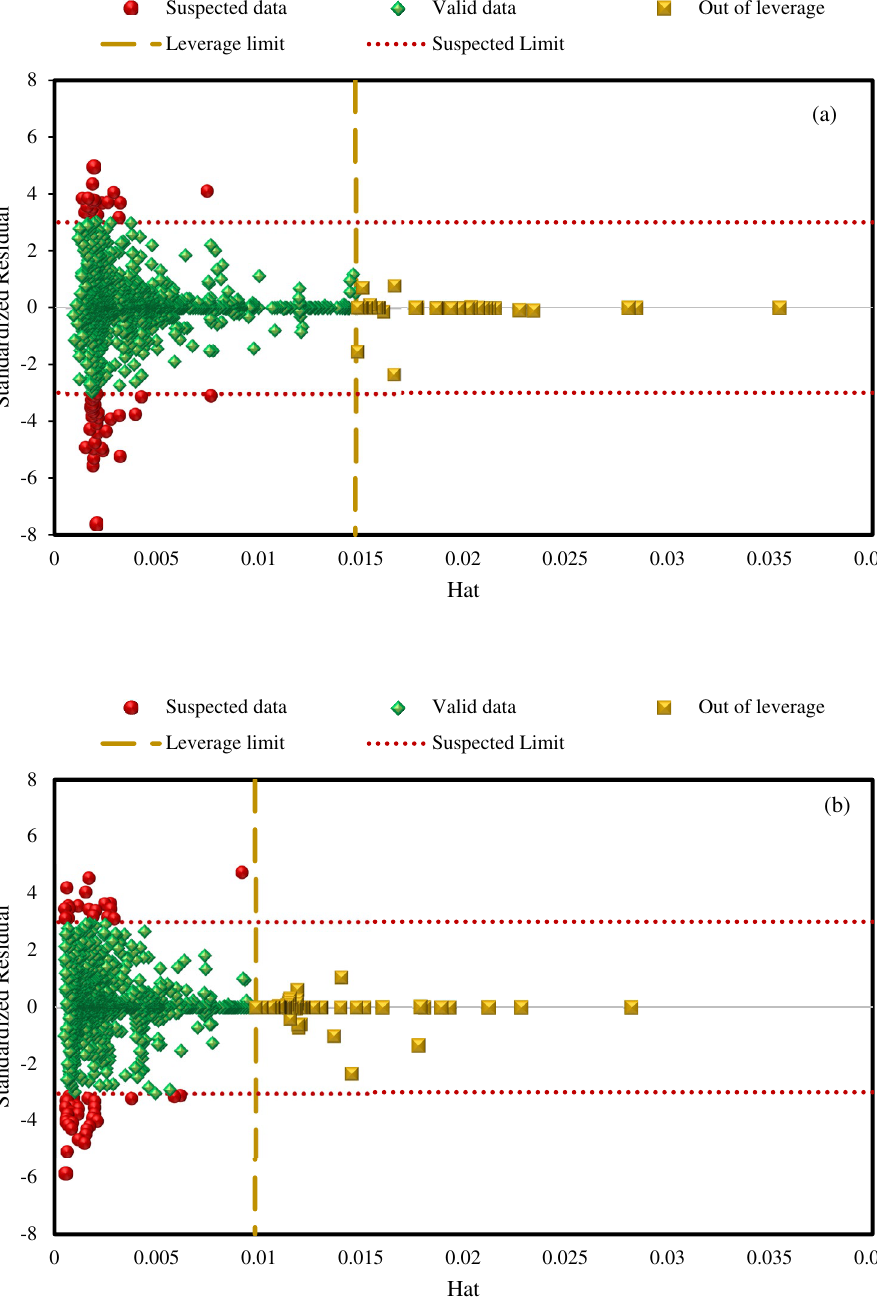
Figure 12. Detection of applicability area, suspected data, and outliers of AdaBoost-SVR models developed with ( a ) 8 inputs and ( b ) 5